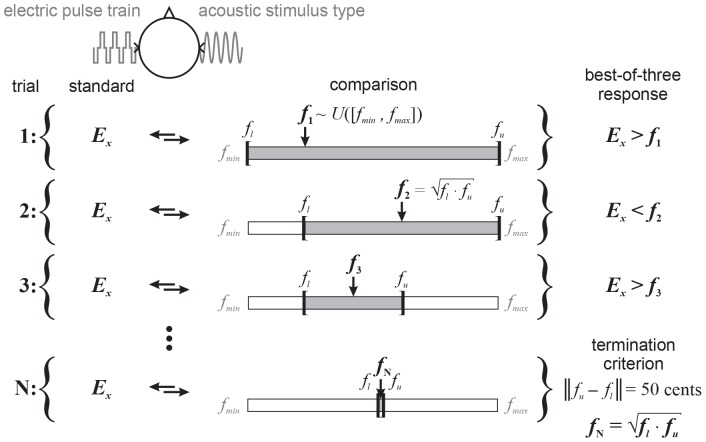
Illustration of the binary search procedure: each trial consists of a standard electric pulse train fixed in electrode position (Ex) throughout a given pitch matching run (trials 1 to N), and an acoustic stimulus type. Subjects are asked to indicate whether the standard or comparison is higher in pitch, with the order of presentation randomized between trials. The (center) frequency (fx,x ∈ {1,2,3,…,N}) of the acoustic stimulus is adaptively changed according to their response, which is evaluated in a best-of-three format for each trial. The starting frequency is randomly drawn from a uniform distribution, i.e., f1∼U([fmin,fmax]). The pitch matching range [fl,fu] initially has the same lower and upper boundaries. In this illustration, the electric stimulus is perceived higher in pitch than the acoustic stimulus at the starting frequency (trial 1), i.e., Ex > f1. Consequently, the lower boundary is set to that frequency and the next frequency (trial 2) set to the geometric mean of the current lower and upper boundaries, i.e., f2=fl⋅fu. The electric stimulus is then perceived lower in pitch than the acoustic stimulus, i.e., Ex < f2, and the upper boundary is set to that frequency. The next frequency (trial 3) is again set to the geometric mean of the current boundaries. This iterative process is terminated (trial N) when the difference between lower and upper boundaries is a quarter-tone (i.e., 50 cents). The final pitch match fN is defined as the geometric mean of the final boundaries.